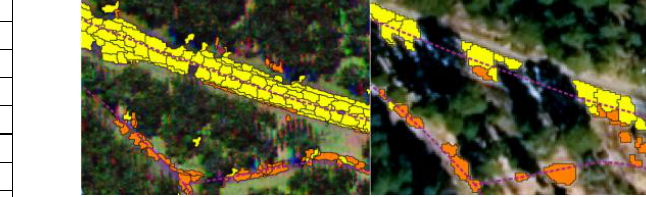
Table 1. Accuracy estimates for the land cover classification.